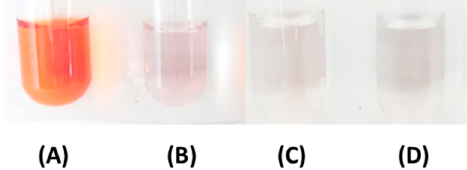
Figure 2. Color changes of 1 mM catechin treated ( A ) without aluminum chloride (AlCl 3 ) and ( B ) with 1 mM AlCl 3 under blue light irradiation (BLI) at 20 W / m 2 for 120 min, and 1 mM catechin treated ( C ) without AlCl 3 and ( D ) with 1 mM AlCl 3 in the dark.